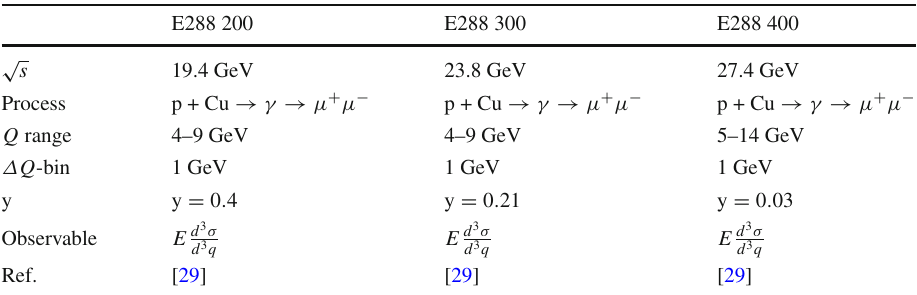
Table 2 The characteristics of the data measured at E288